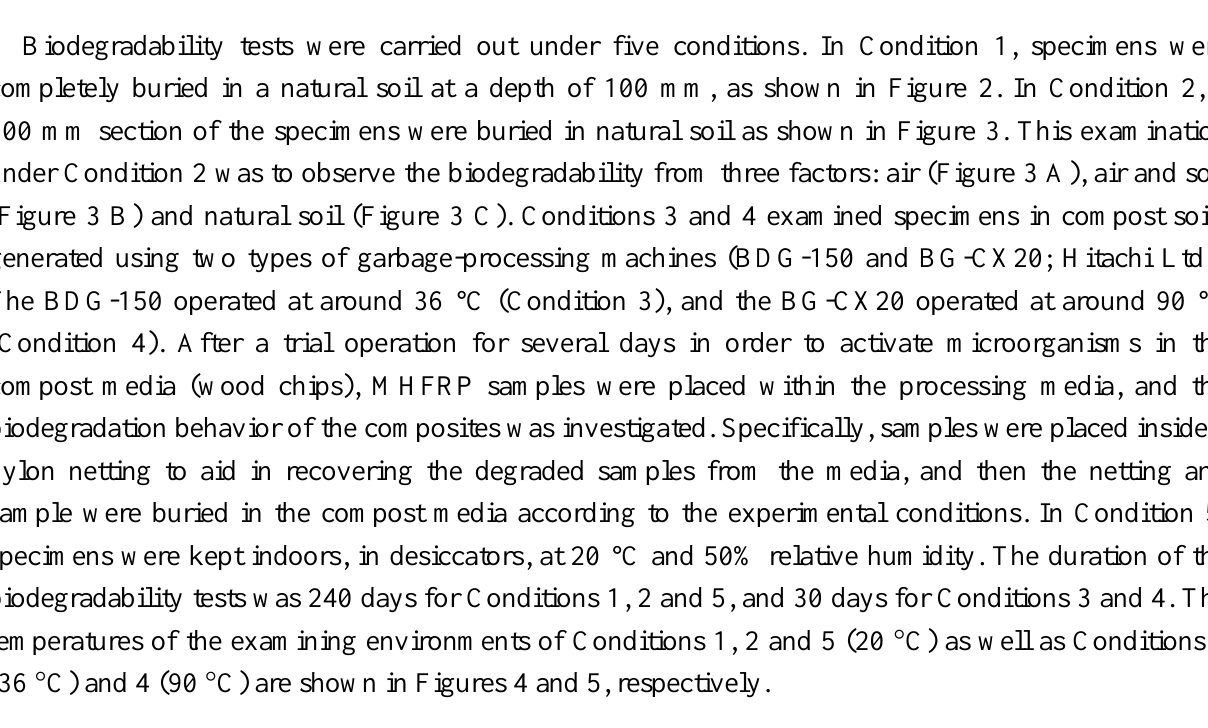
Figure 2. Schematic illustration of the biodegradable test (Condition 1).